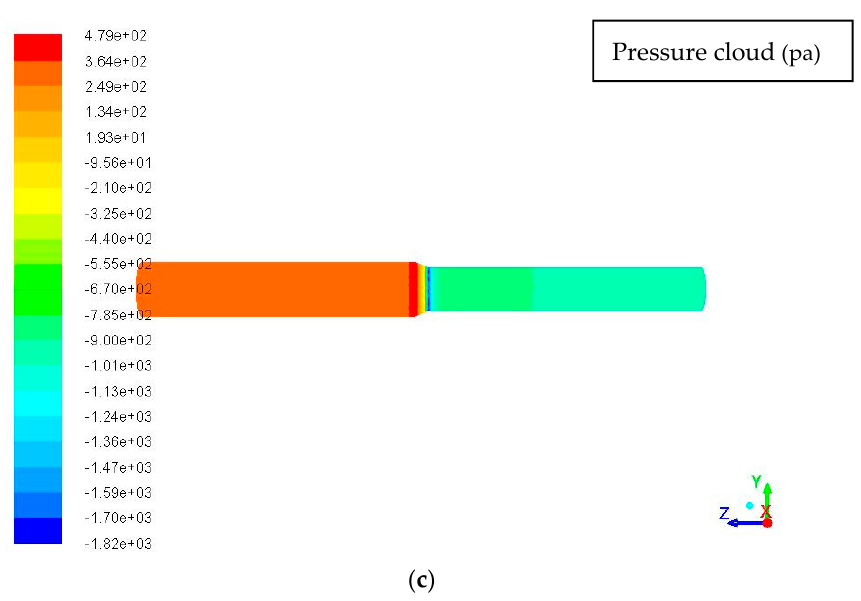
Figure 11. Numerical simulation results for outlet pipe diameter 130 mm and flow rate 0.1 m/s; ( a ) Wall shear stress cloud; ( b ) Velocity cloud; ( c ) Pressure cloud.